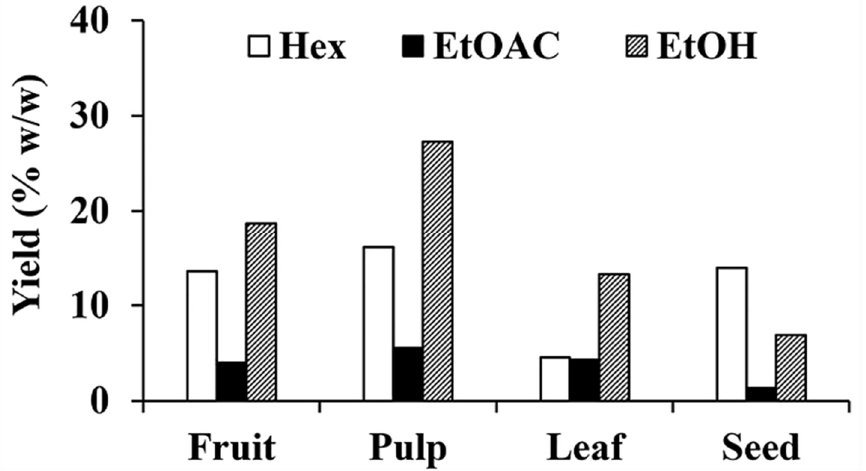
Figure 1. Yields of C. carandas extracts sequentially extracted using n -hexane (Hex), ethyl acetate (EtOAc), and 95% ethanol (EtOH), respectively.